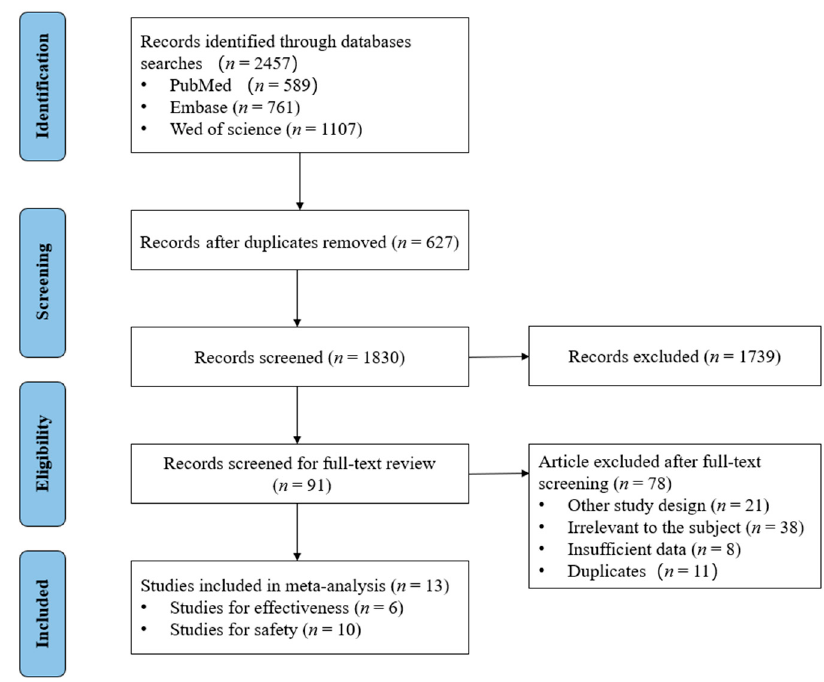
Figure 1. Flowchart of studies selection.